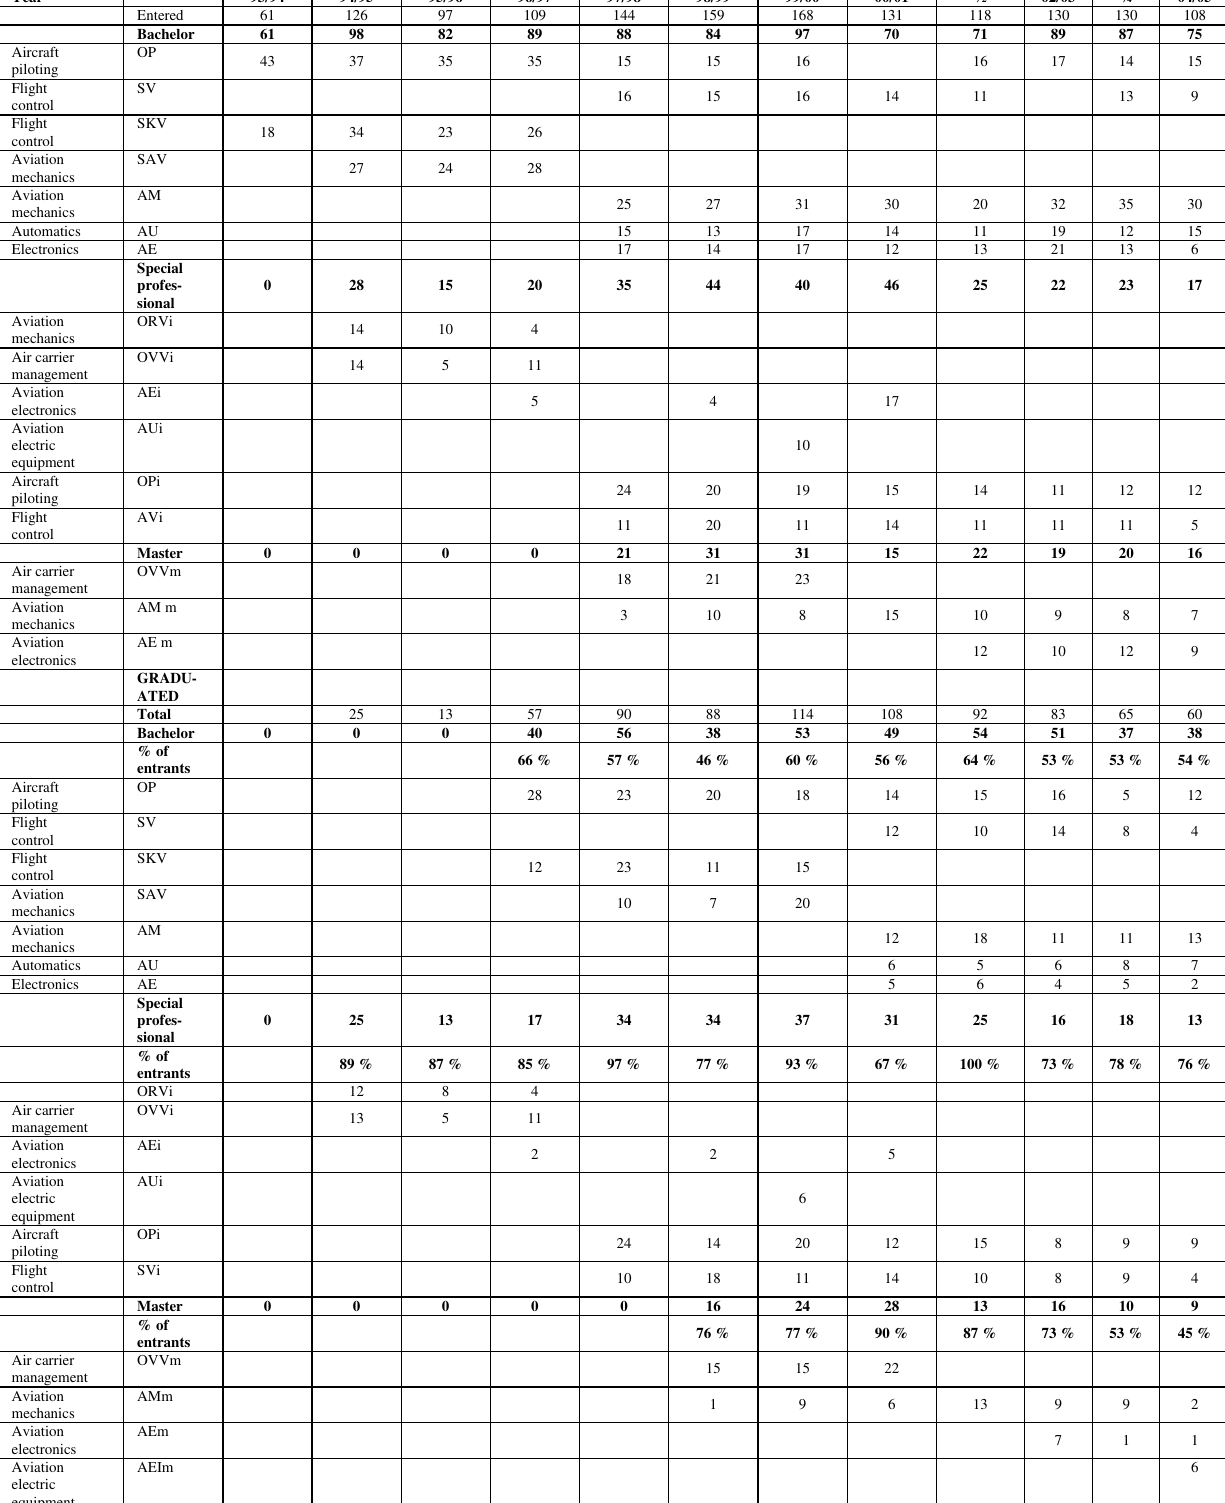
Table 3. VGTU AGAI entrant and graduate dynamics